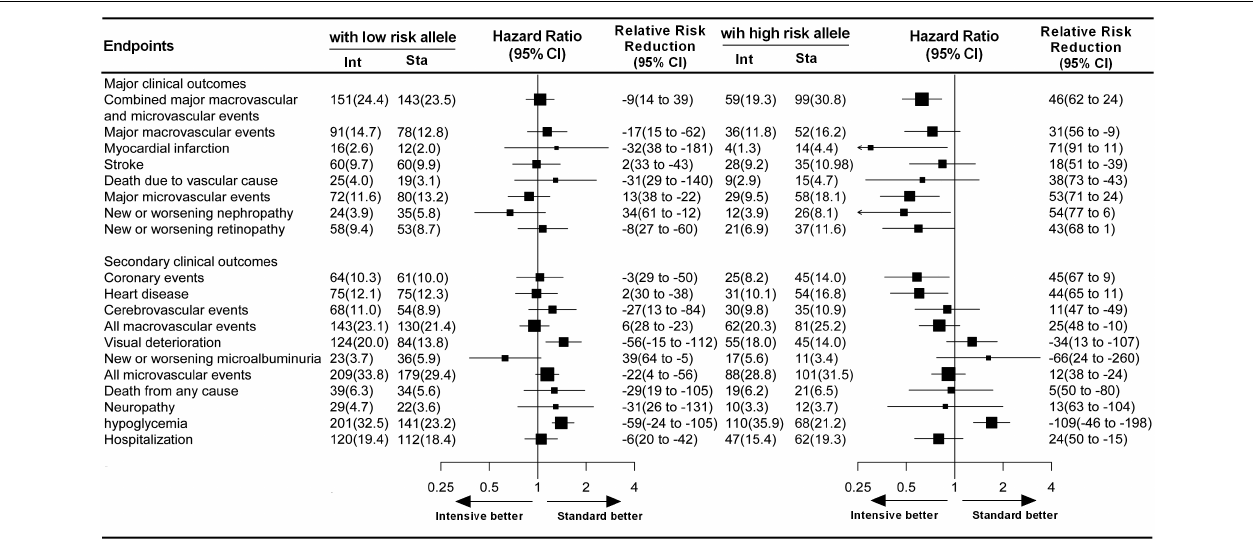
FIGURE 4 | Effect of glucose treatment on primary and secondary endpoints among patients with high-risk and low-risk alleles. For each sub-endpoint, black squares represent point estimates, with the area of the square proportional to the number of events, and horizontal lines represent the 95% confidence interval. The hazard ratios and relative risk reductions are provided for intensive glucose control as compared with standard glucose control in patients with high-risk and low-risk alleles.